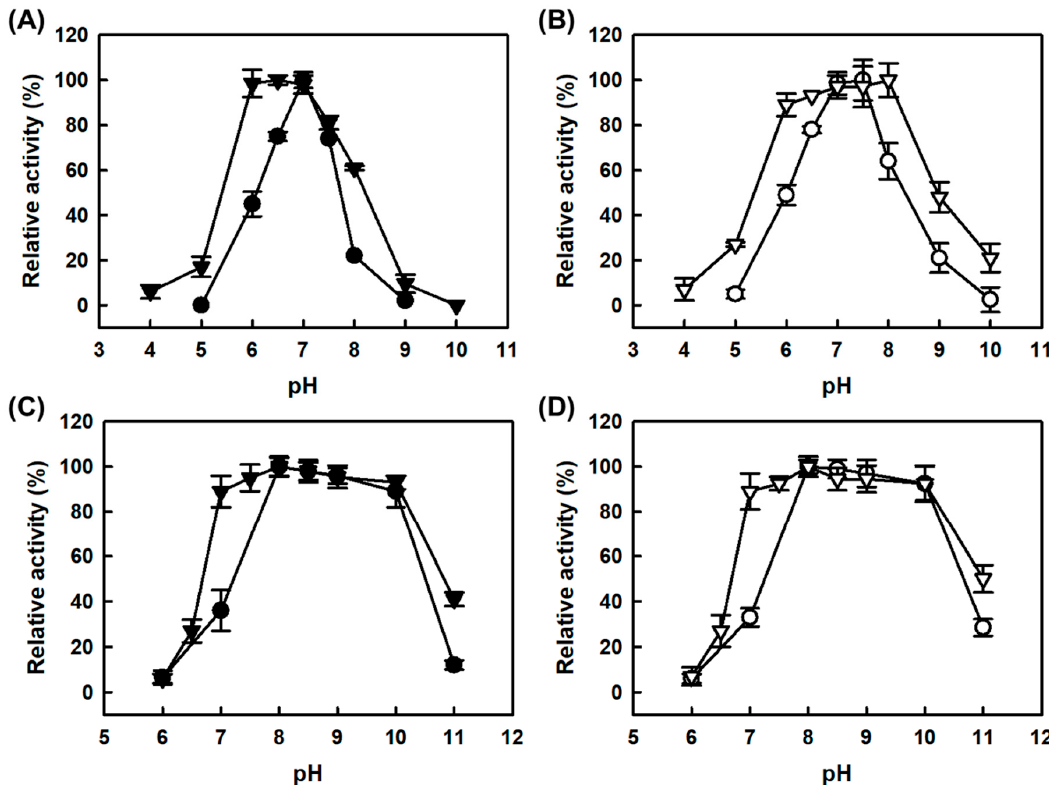
Figure 3. Effect of pH on activity of free and CLEAs enzymes. ( A ) Monoamine oxidase activity for free AMAO2 ( ▼ ) and MAPO ( ● ) using tyramine as the substrate, ( B ) monoamine oxidase activity for combi-CLEAs ( ▽) and CLEAs-MAPO ( ○ ) using tyramine as the substrate, ( C ) putrescine oxidase activity for free APUO ( ▼ ) and MAPO ( ● ) using putrescine as the substrate, ( D ) putrescine oxidase activity for combi-CLEAs ( ▽) and CLEAs-MAPO ( ○ ) using putrescine as the substrate. The activities of amine oxidases were measured according to the peroxidase-coupled assay [16]. Upon determining optimal temperatures of the enzymes, the reactions were carried out at 50 ° C and a pH of 4.0–10.0.